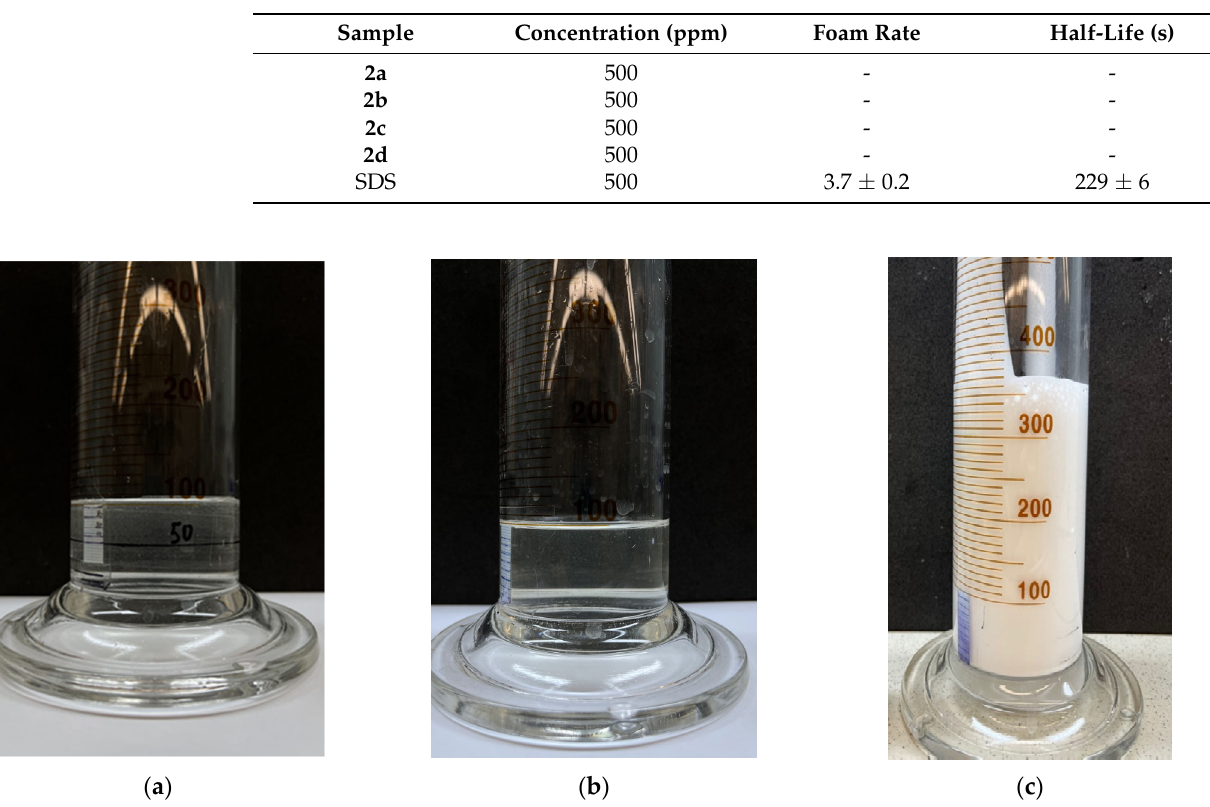
Figure 4. Foam appearance of synthesized compounds: ( a ) 2b ; ( b ) 2d ; and ( c ) SDS.